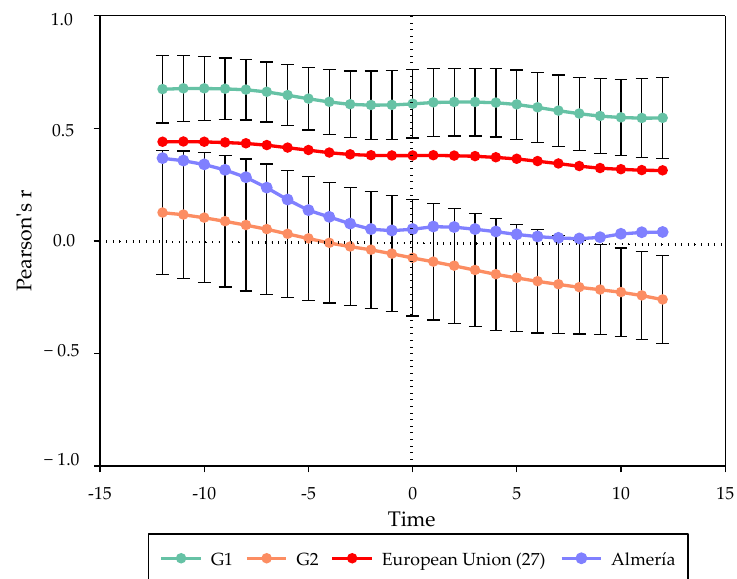
Figure 2. Evolution of Pearson’s coefficient in the “packing” plastic ratio versus the monthly cost of a barrel of oil with a monthly lag from t − 12 to t + 12. Source: own elaboration based on data obtained from Eurostat (consulted on 17 May 2021), EIA (consulted on 17 May 2021) and CAGPDR (consulted on 2 November 2021).